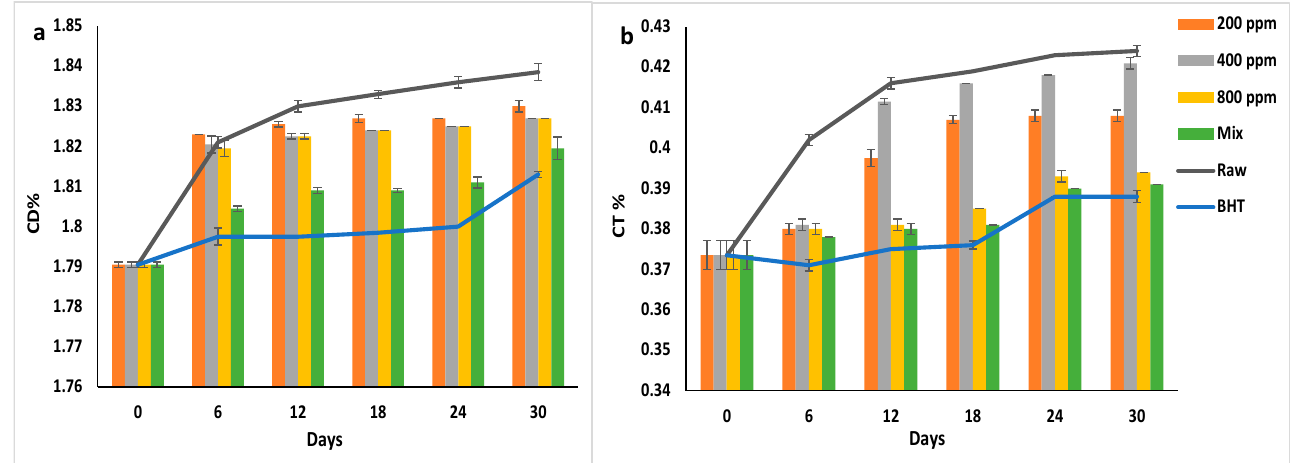
Figure 7. ( a ) Conjugated dienes (CD%) and ( b ) Conjugated trienes (CT%) of raw soybean oil (without antioxidants) and soybean oil enriched with PGG leaf extract (200, 400, and 800 ppm), BHT (200 ppm), and a PGG/BHT mixture (400/100 ppm) during the accelerated storage days (30 days) at 65 °C. bonds in the fatty acids ( p < 0.05). CT% gradually increased from 0.37 ± 0.00%